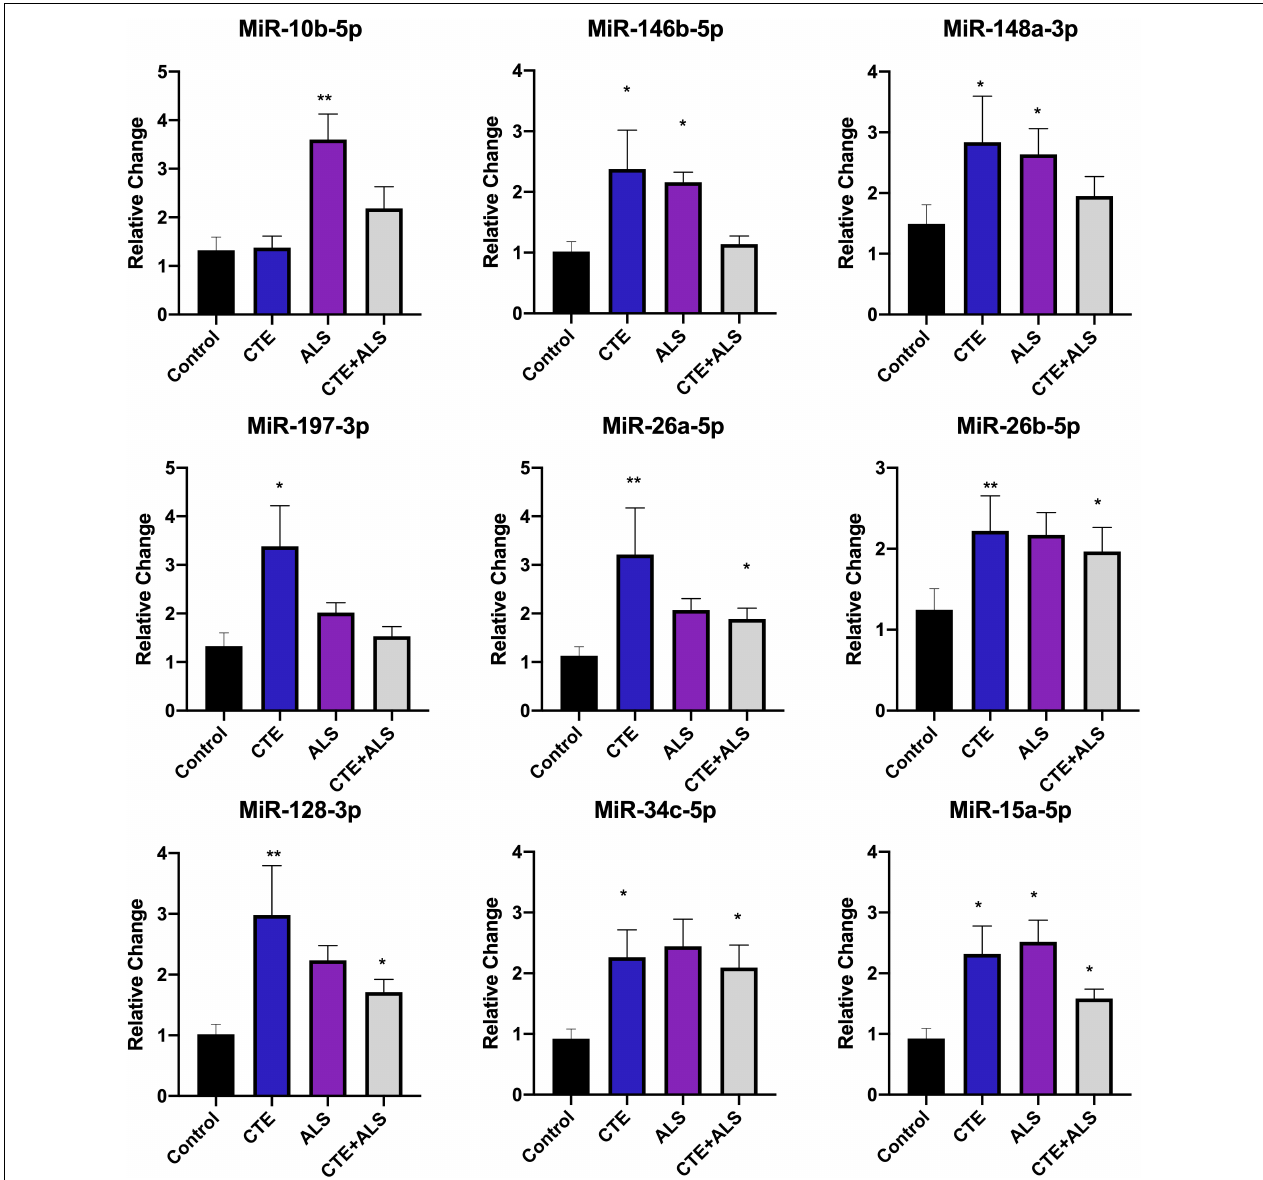
FIGURE 2 | Cell Growth and Differentiation miRNAs significantly altered in CTE, ALS, or CTE + ALS. MiR-10b was upregulated in ALS alone. MiR-146b-5p and miR-148a-3p were significantly upregulated in non-comorbid ALS and CTE. MiR-197-3p was upregulated in CTE. Four miRNAs, miR-26a-5p,